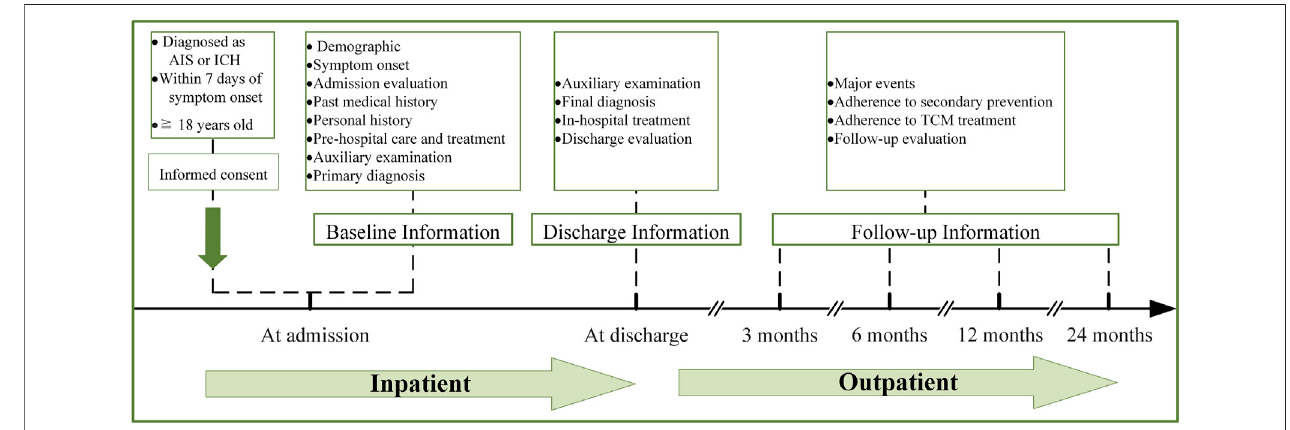
FIGURE1| The fl owchartoftheCASES-TCMstudy;Abbreviations:AIS,acuteischemicstroke;ICH,intracerebralhemorrhage;TCM,traditionalChinesemedicine.